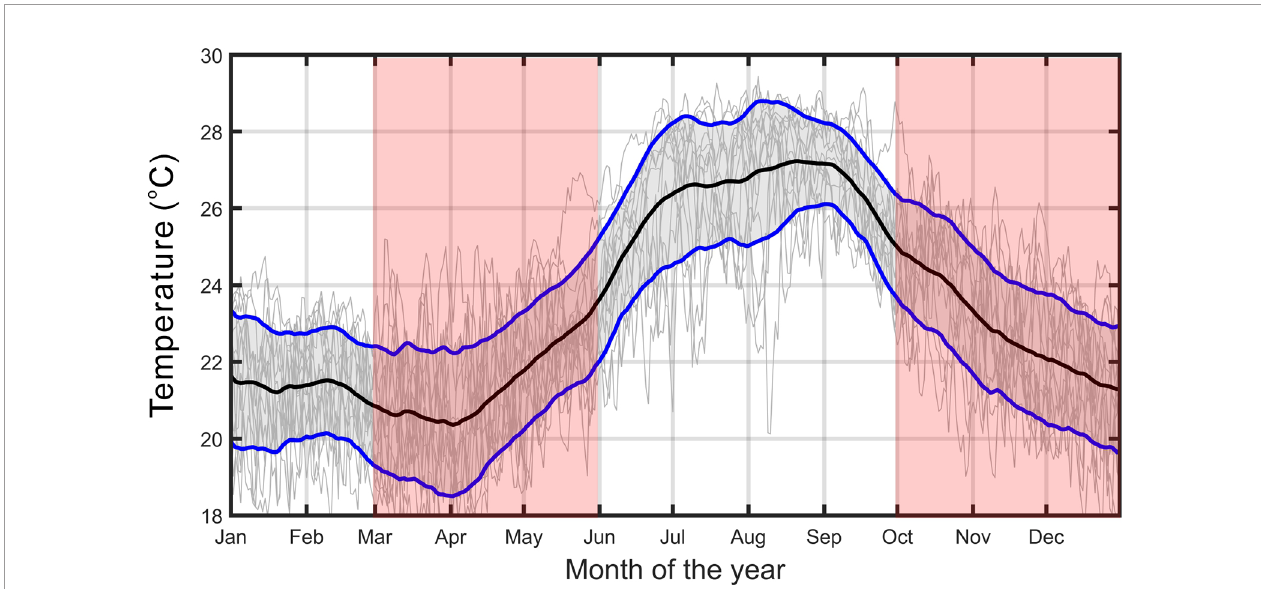
FIGURE 3 | The 20-day low-pass- fi ltered daily mean temperature (black line) calculated from the temperature observed at the Peng-jia-yu isle from 2008 to 2021. The ± one standard deviation from the mean value is bounded by the two blue lines. The gray lines are the raw temperature records of each year. Transparent pink shading indicates the spawning periods of the swordtip squid in the